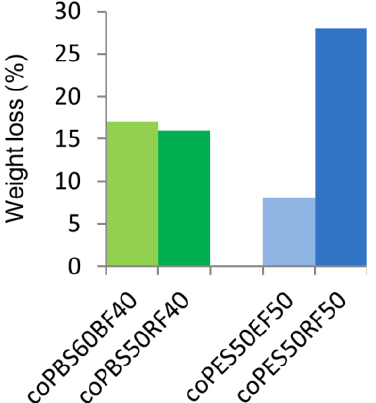
Figure 12. Compared biodegradability (% of weight lost after incubation with lipases) of butylene and ethylene succinate-furanoate copolyesters differing in the content in resorcinol-derived units. Data reported by Morales-Huerta et al. [14] for co PBS 60 BF 40 , and Terzoupolou et al. [15] for co PES 50 EF 50 are included for comparison.